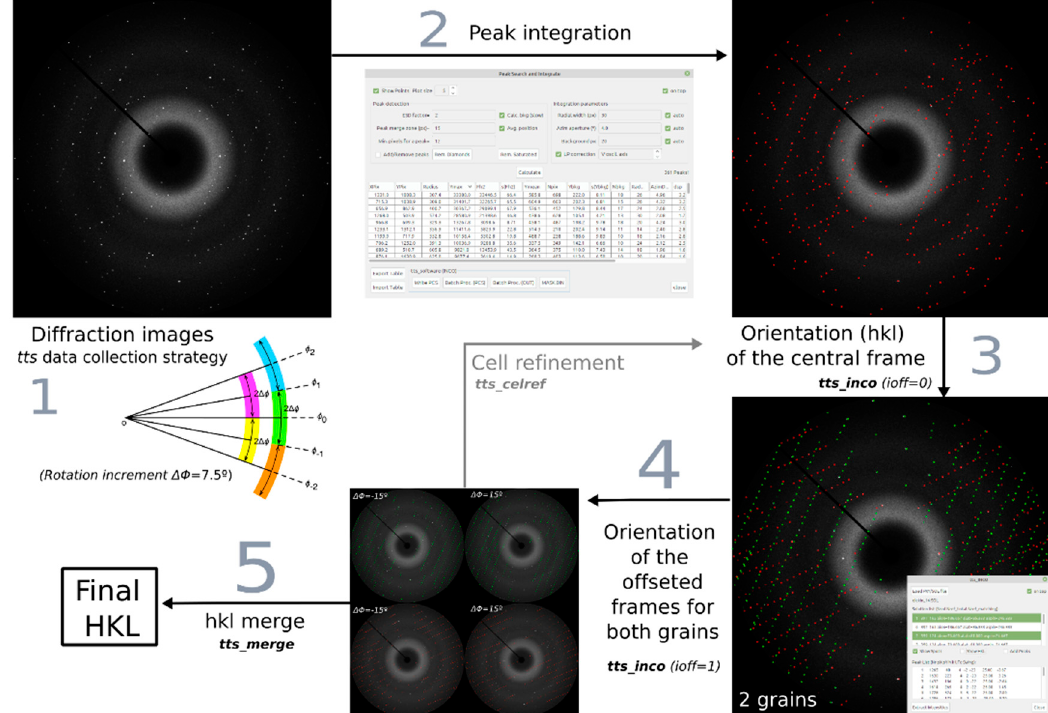
Figure 2. Workflow of the application of the tts- µ XRD methodology. In the first step data are collected using the rotation method with wide and partially-overlapped angular increments. The second step is the integration of all the reflections on the images. Then, in the third step the orientation of the grain(s) contained in the central frame is determined. In this example (Dickinsonite phosphate mineral) there are two grains filling the measured microvolume. In the next step the orientation of the offset frames for the different grains is determined and, if necessary, the unit cell is refined. Finally, the last step is the scaling and merging of all the partial hkl from the different grains and